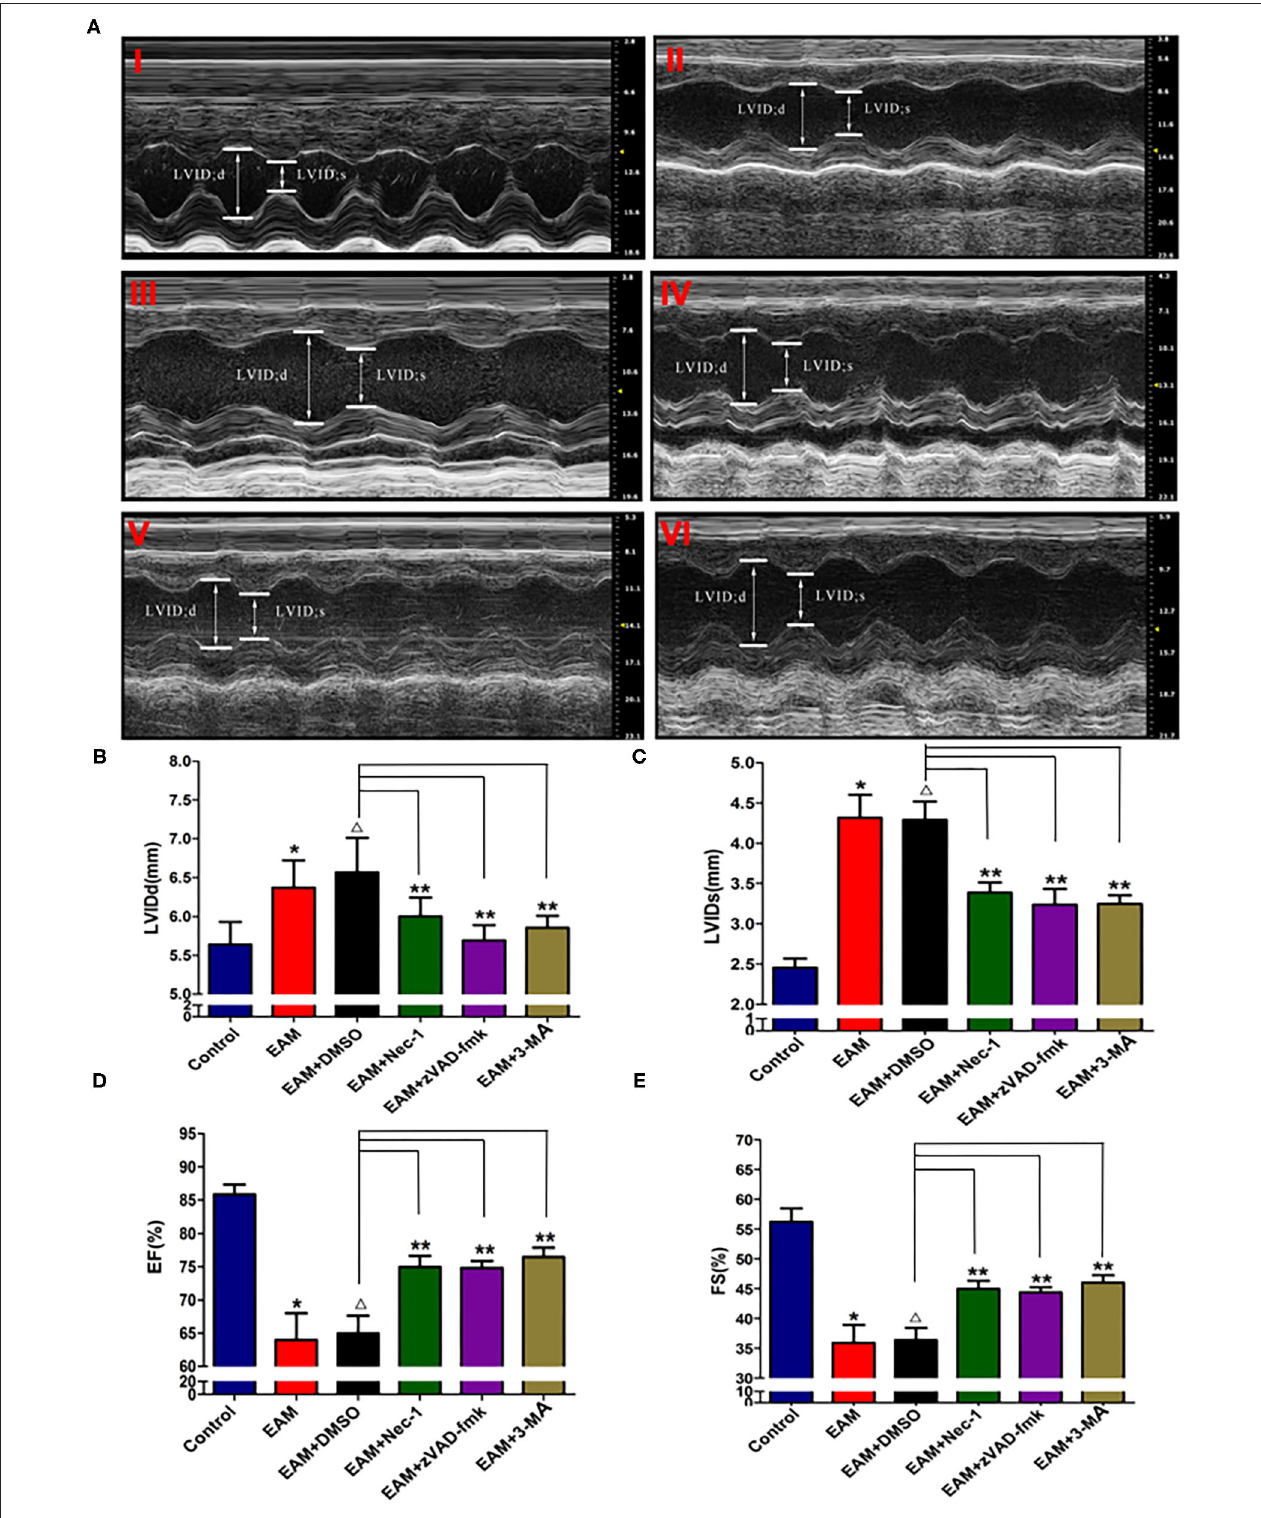
FIGURE 4 | The level of LVIDd/LVIDs/EF/FS in “early” stage of myocarditis in EAM mice with inhibitors by echocardiography. (A) Echocardiographic images of control and EAM mice (3W) (I—control, II—EAM, III—EAM + DMSO, IV—EAM + Nec-1, V—EAM + zVAD-fmk, VI—EAM + 3Ma). (B–E) Quantification of LVIDd, LVIDs, EF, and FS in the “early” stage of myocarditis from control groups. A horizontal bar is shown to indicate compared groups. All data are presented as mean ± SEM. A Student’s t -test was performed for the control group and the EAM group, * p < 0.05 vs. control group ** p < 0.01 vs. EAM + DMSO group, 1 p > 0.05 vs. EAM group.